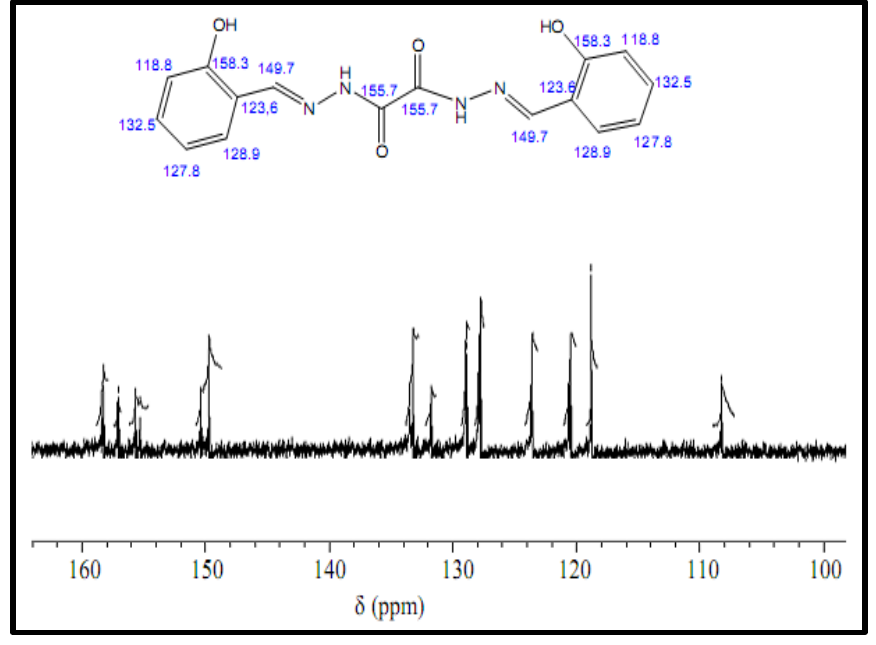
Figure 3. 13 C NMR spectrum of HAO in DMSO- d 6 at RT.